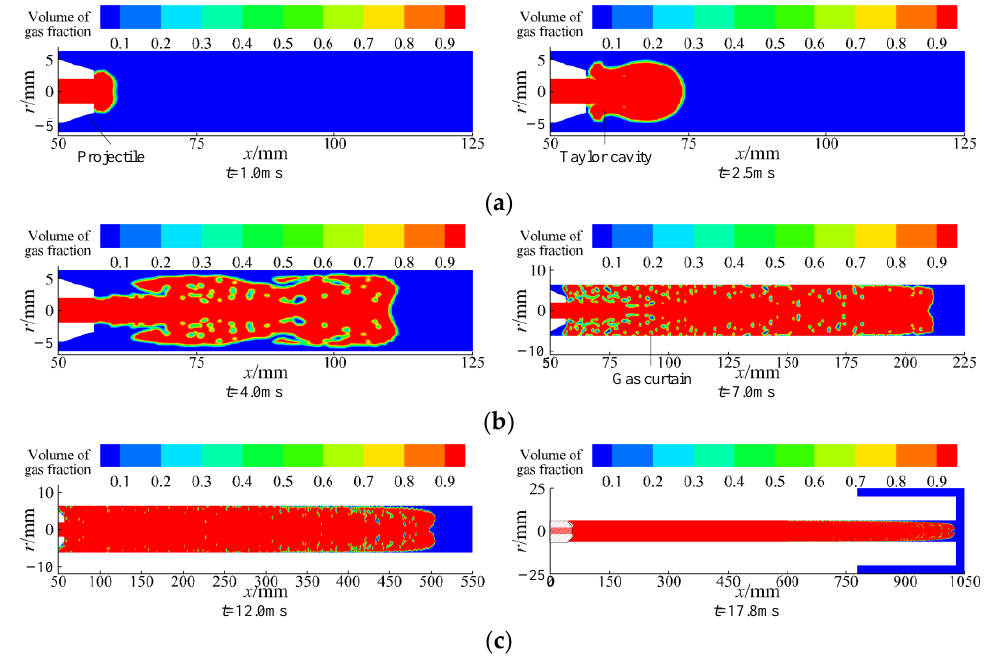
Figure 7. The gas-curtain evolution process (projectile B). ( a ) The first stage; ( b ) the second stage; ( c ) the third stage.